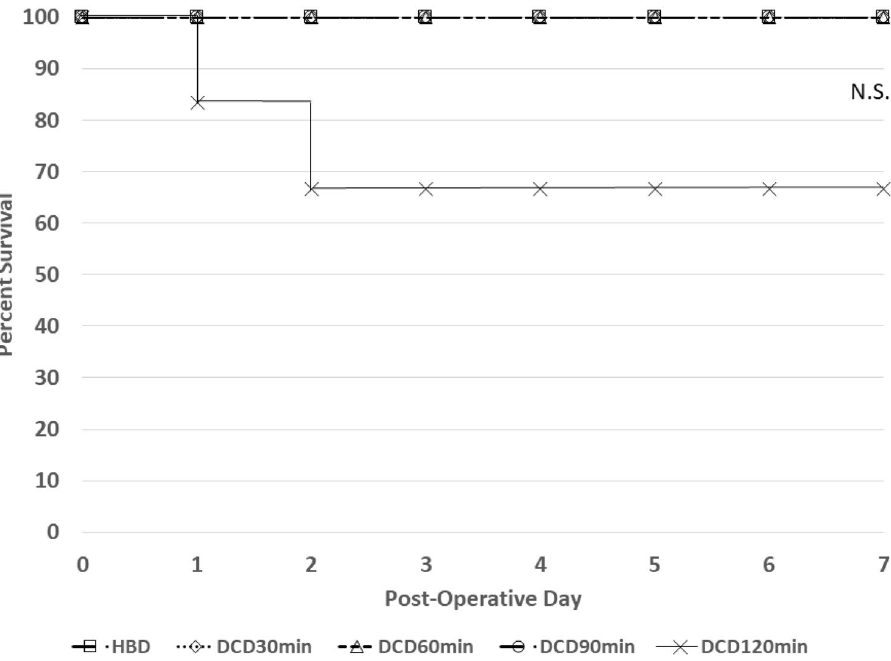
Figure 2. Recipient survival following transplantation of grafts subjected to no warm ischemia (HBD) or progressive warm ischemia of 30, 60, 90, or 120 min followed by 8 h of static cold storage. Survival is depicted in a Kaplan–Meier plot. HBD heart beating donor, DCD Donation after Cardiac Death. HBD heart beating donor. N.S. Not